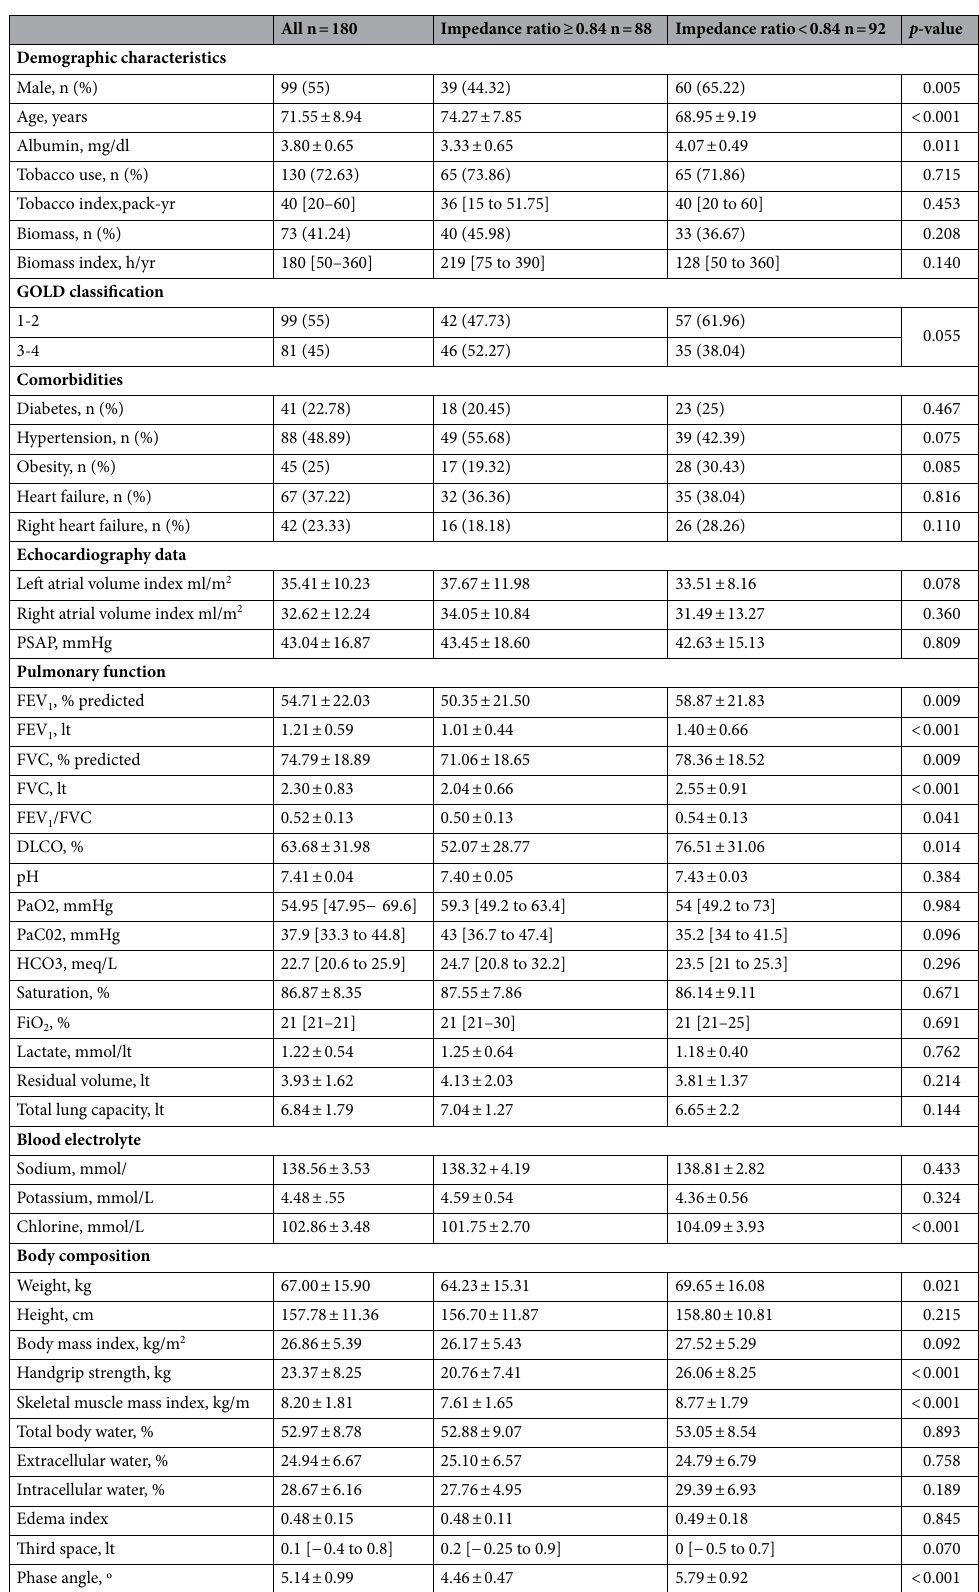
Table 1. Clinical characteristics according to impedance ratio. GOLD classification Global Initiative for Chronic Obstructive Lung Disease classification, FEV 1 Forced expiratory volume in 1 s, Forced vital capacity, DLCO Carbon monoxide diffusing capacity, PaO 2 Partial pressure of oxygen, PaCO 2 Partial pressure of carbon dioxide, HCO 3 Bicarbonate, FiO 2 Fraction of inspiratory